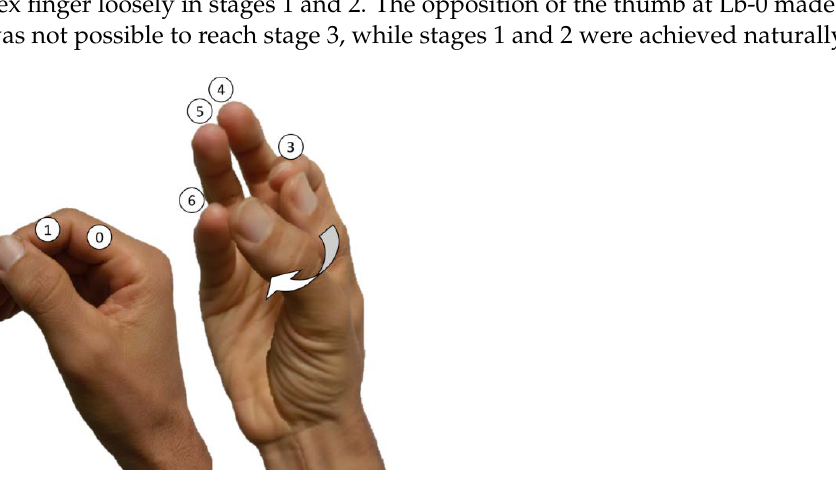
Figure 5. Definition of the seven points for the Kapandji opposition test in a human hand.